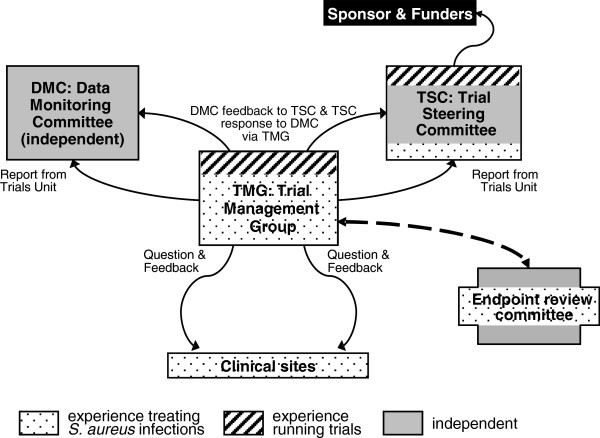
Trial organogram.